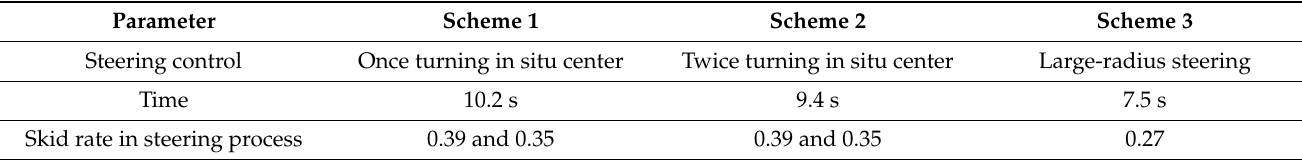
Figure 9. Skid and slip rate. ( a ) scheme 1; ( b ) scheme 2; ( c ) scheme 3. Table 3. Related data comparison table of the tracked robot.